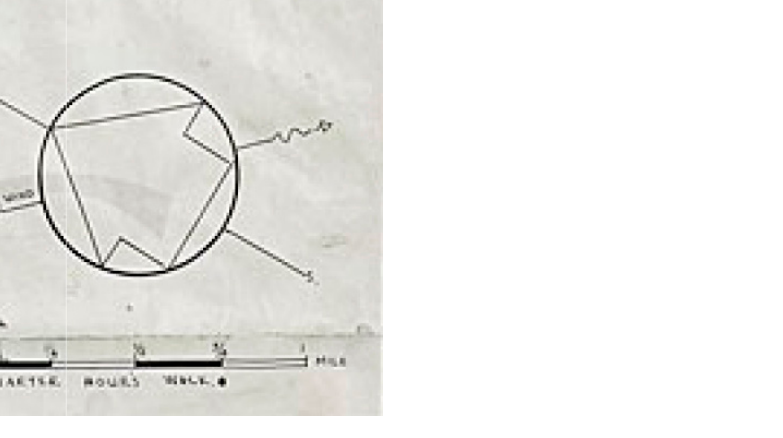
Figure 8. Quarter of an hour walk analysis of Chandigarh Master Plan. Source: Authors.